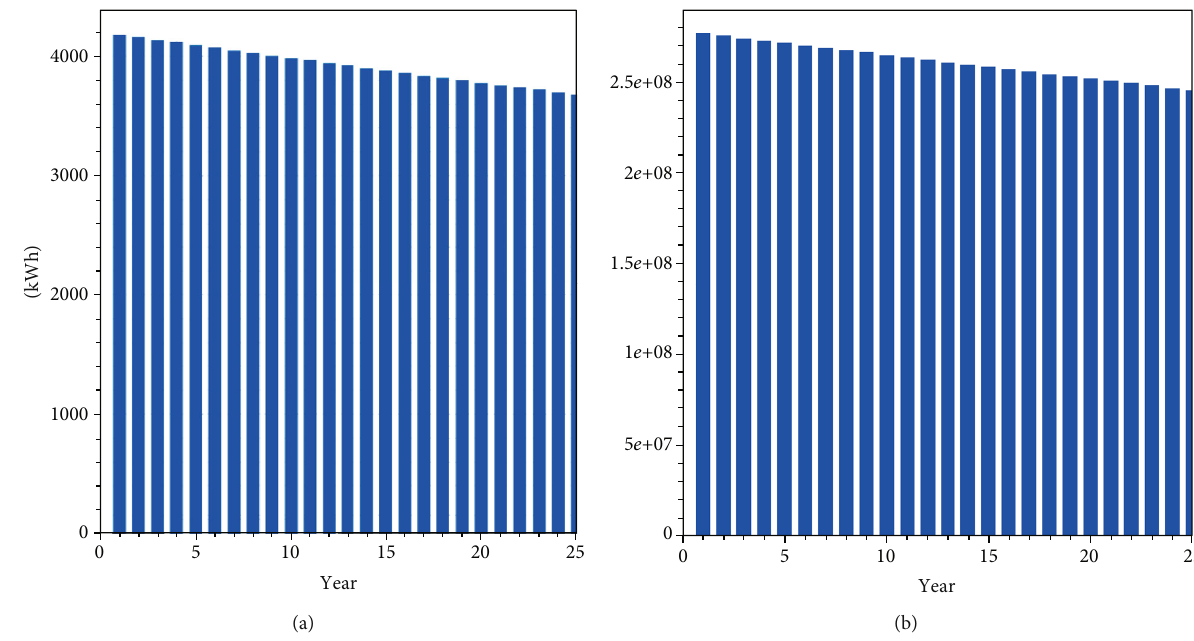
Figure 21: Total yearly lifetime energy yield (a) by the PV system and (b) by the CSP